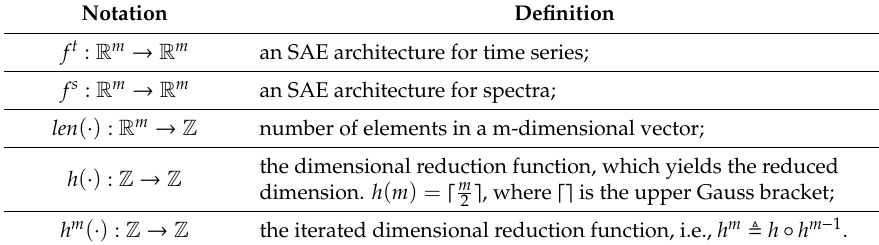
Table 2. Notations of functions.